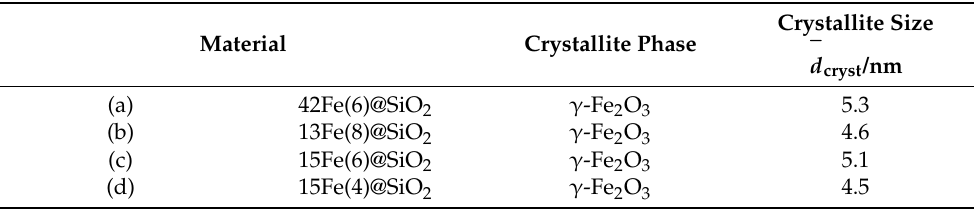
(hkl) = 311 estimated via Scherrer